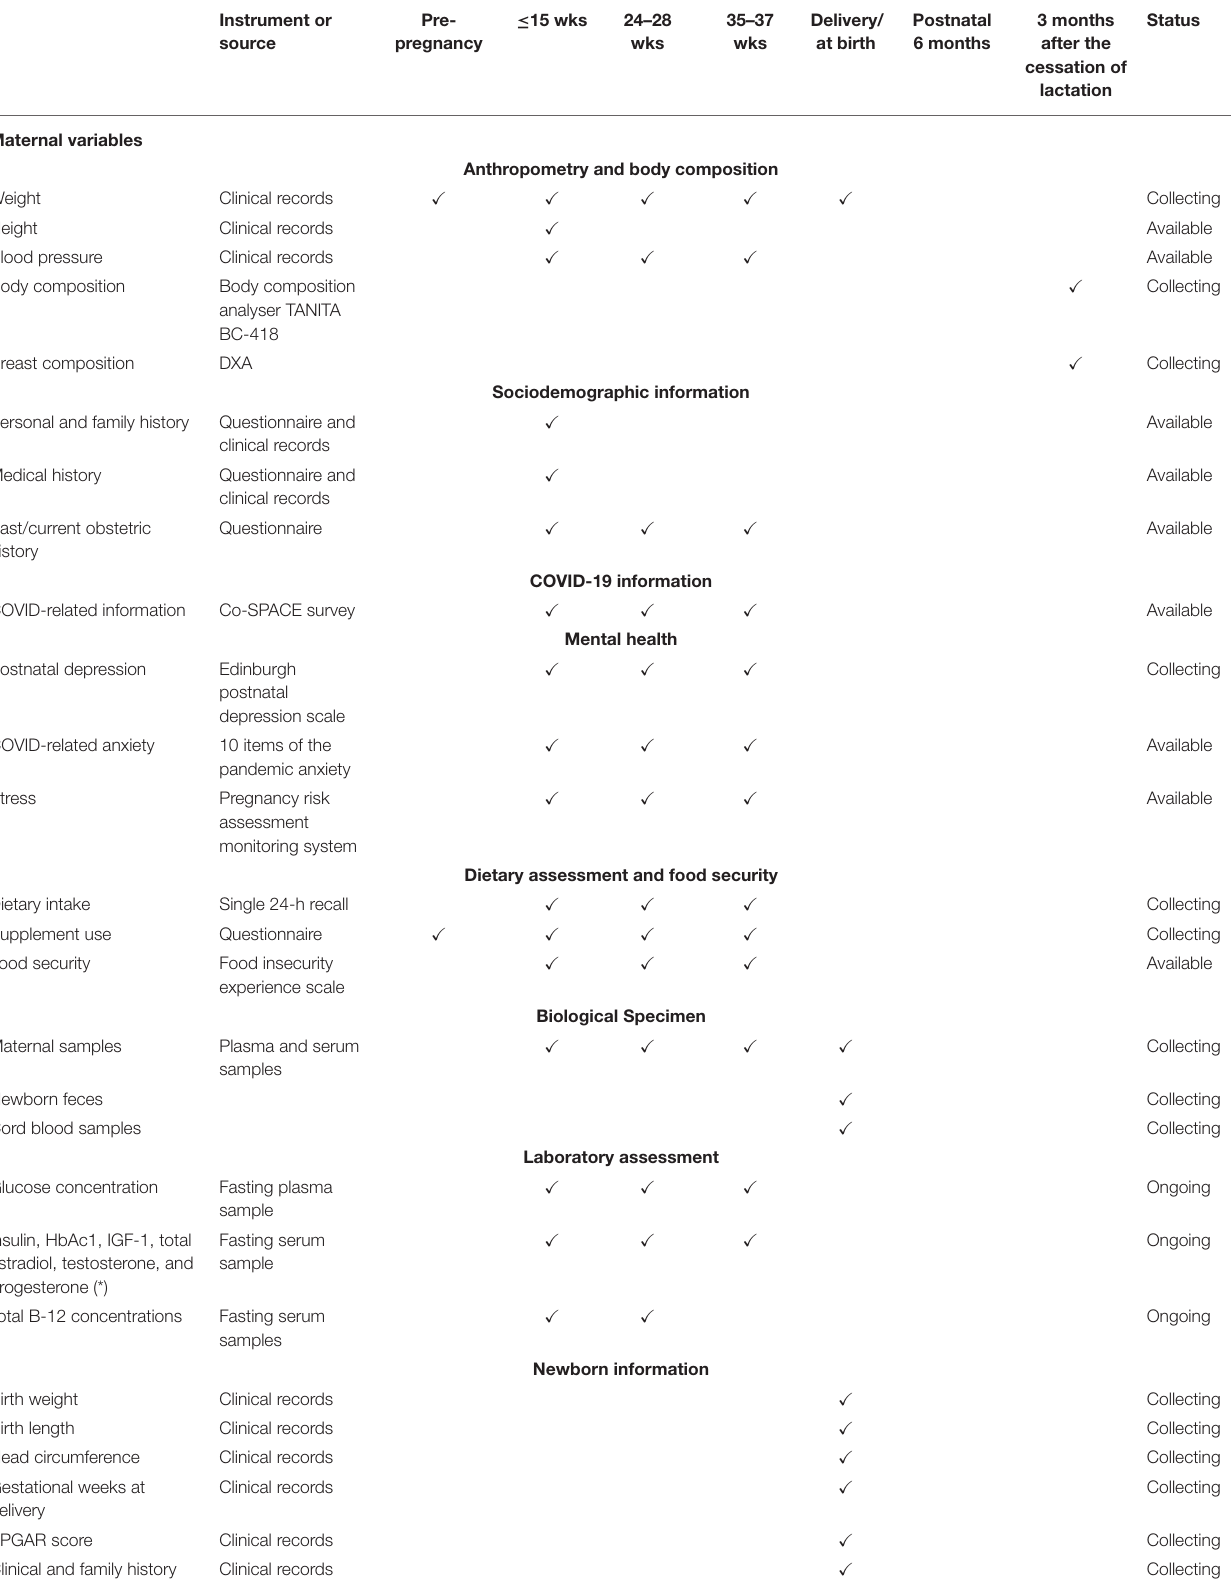
TABLE 1 | Study variables of the CHiMINCs -II